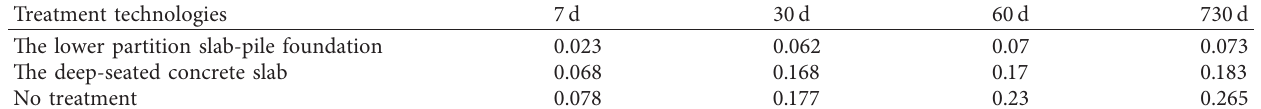
Table 2: Grading rate i (%) of different treatment technologies.